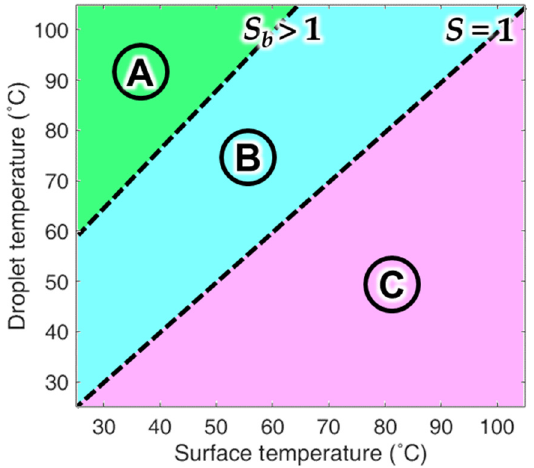
Figure 3. DB map showing the zones divided by boundary lines.